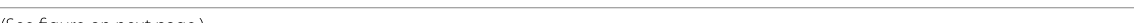
table S1. Cells were washed in 1ml PBS/2%FBS and cen- trifuged at 1200 rpm for 5 min. 150μl PBS/2%FBS was added, and the contents were transferred into the FACS tubes (1μl of each antibody was added to 1 in 100μl PBS/2%FBS). Cells were analyzed on a Gallios flow cytometer, and at least 20,000 gated events were analyzed using Kaluza software (Beckman Coulter).